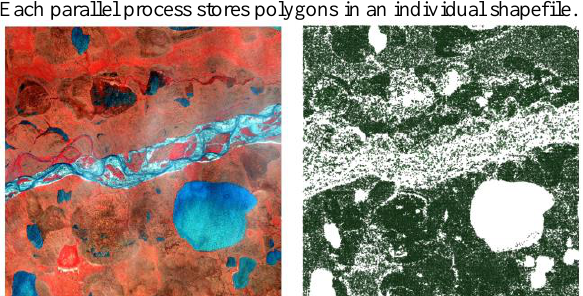
(a) The original satellite image with ice-wedge polygons. (b) Plot of the ice-wedge polygonsImagery © 2016 DigitalGlobe, Inc